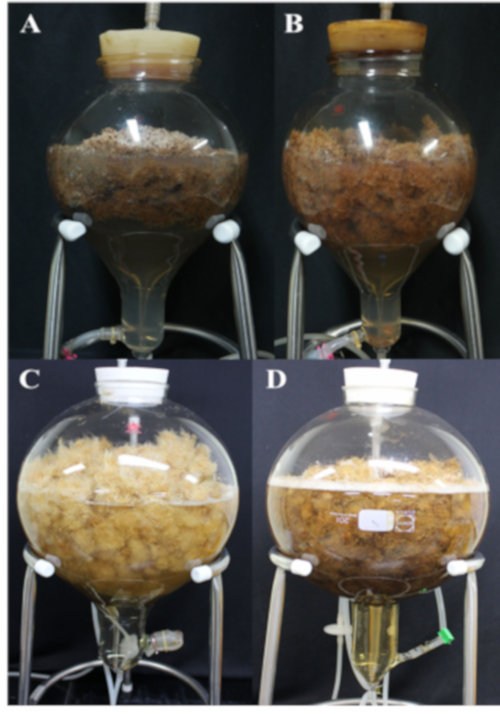
Figure 7. E ff ect of MJ on biomass production in Polygonum multiflorum and Echinacea purpurea adventitious root culture system. ( A , B ) control and 100 µ M MJ in P. multiflorum , ( C , D ) control and 100 µ M MJ in E. purpurea ,